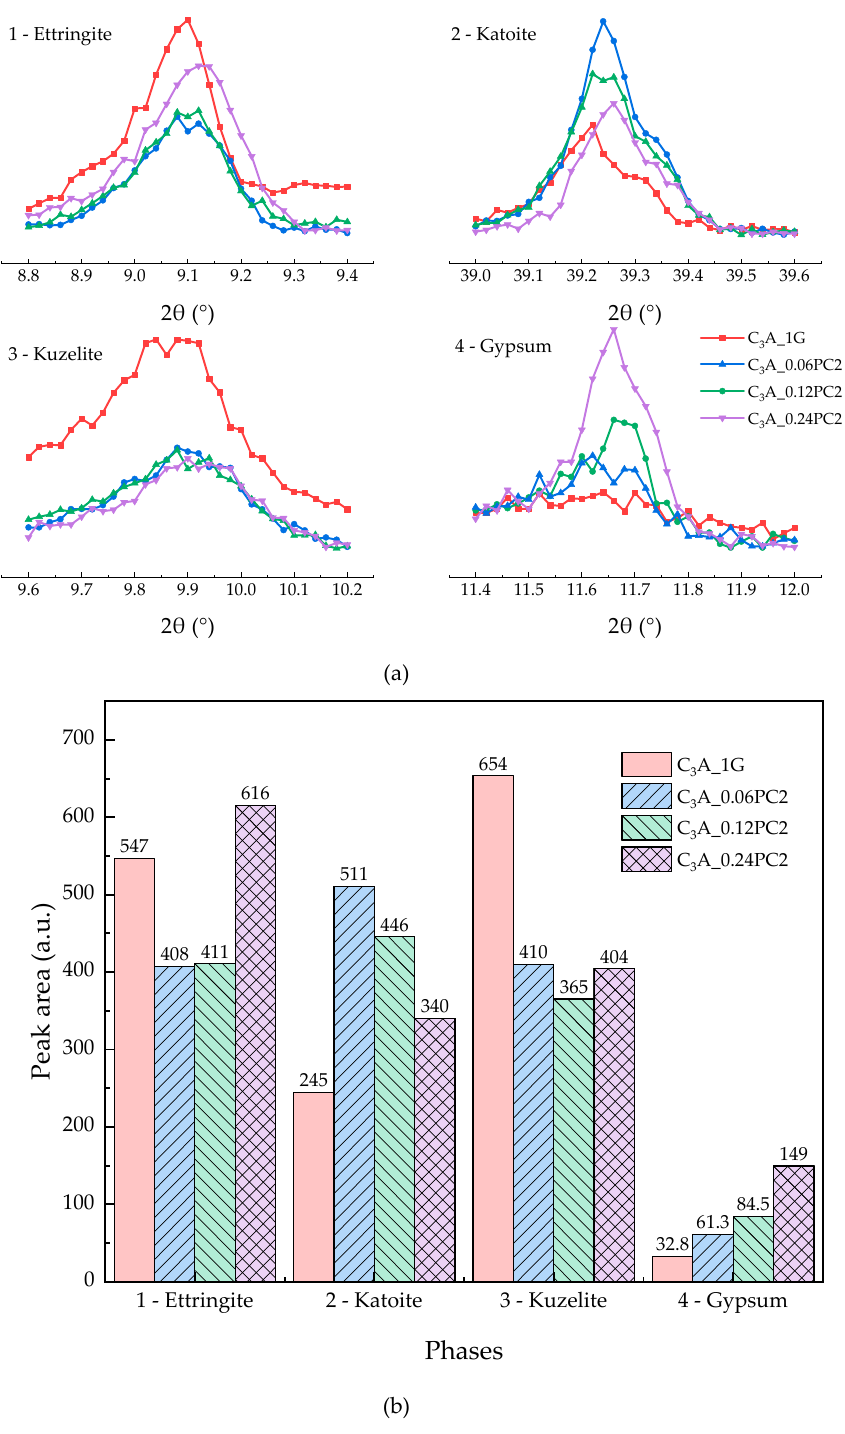
Figure 7. ( a ) XRD patterns of phases obtained from C 3 A-gypsum with different concentrations of PC2 solution after the 24-h hydration. ( b ) XRD peak area of each phase in (a).